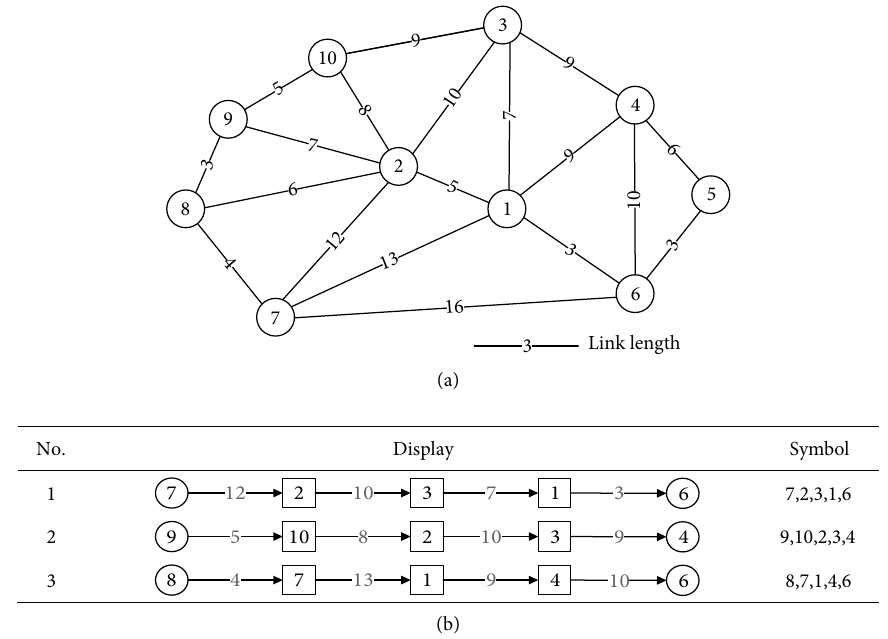
Figure 2: Illustration of example network. (a) Transit network and (b) Route